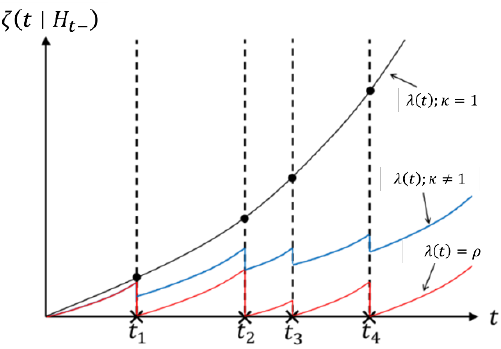
Fig. 1. Schematic illustration of the intensity process of